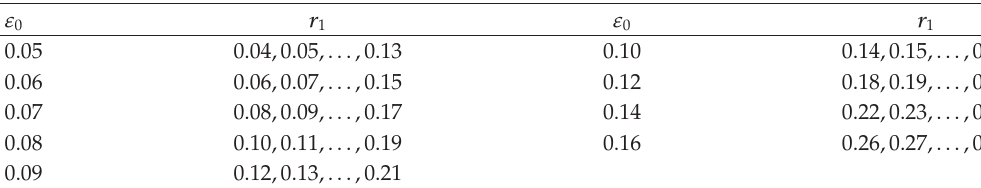
Table 2: Parameters Δ k / k 0 for initial imposed wave